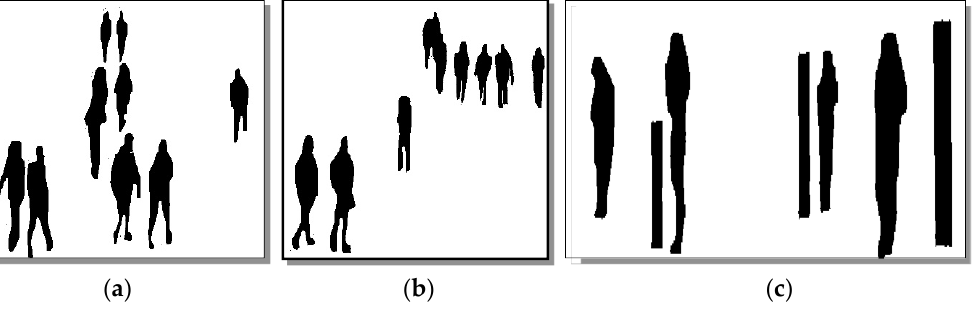
Figure 2. Optimized results of pre-processing step with human and non-human objects ( a ) (( b ) human extraction from crowd scene) and ( c ) human and non-human object extraction in the crowd scene.